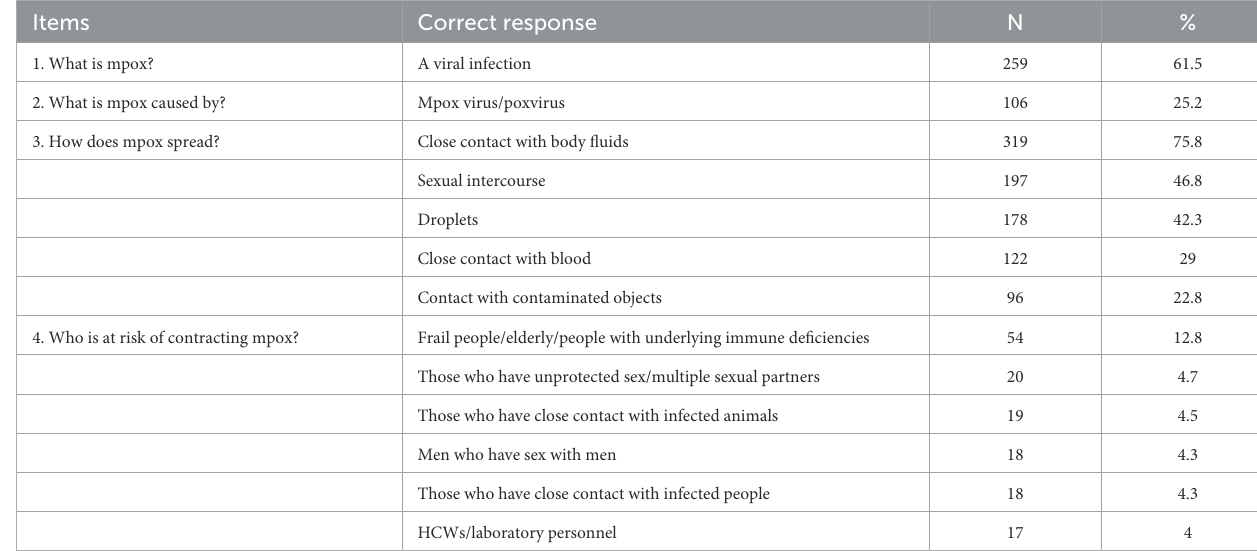
TABLE 2 Frequency of correct responses to the questions assessing mpox